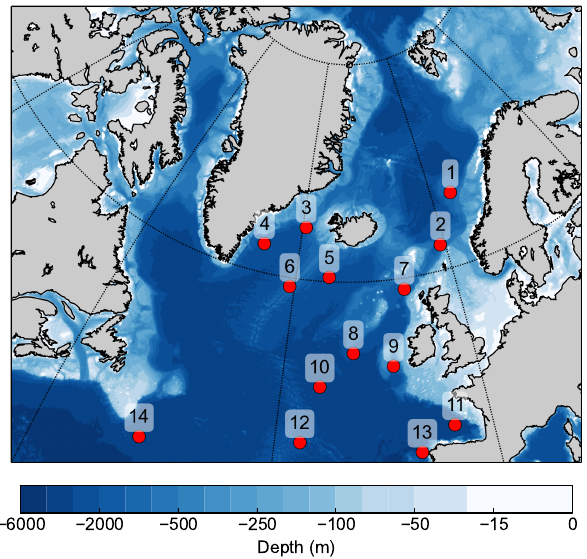
Figure 1. Core locations of the proxy data; numbers correspond to Table 1. Colors indicate bathymetry.